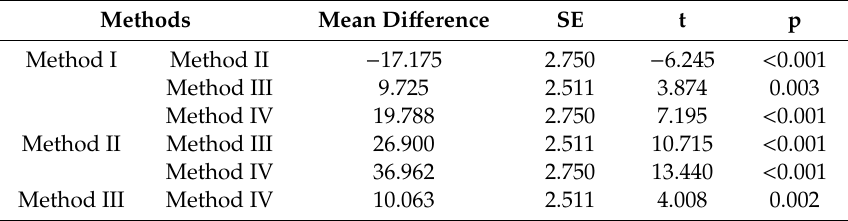
Table 4. Post hoc test—method